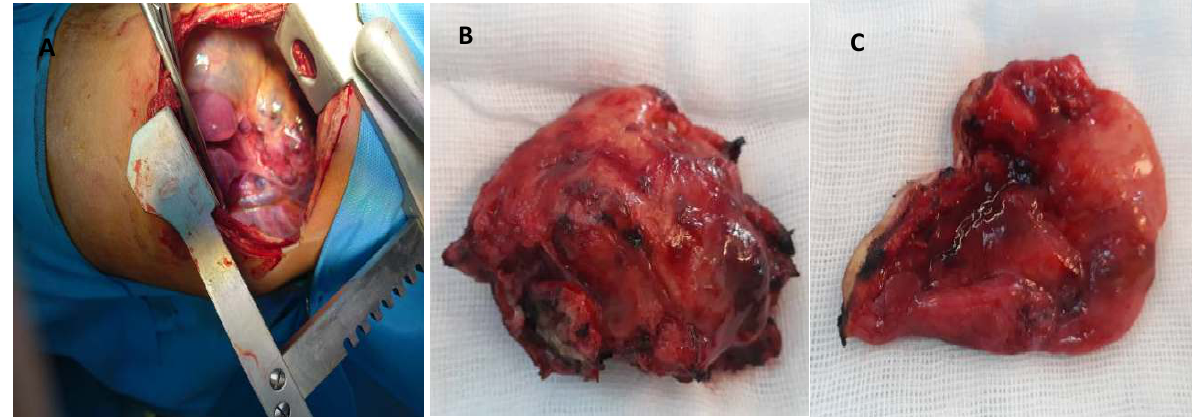
Figure 2: (A) Intraoperative view of Tumor. (B) Anterosuperior mediastinal lesion. (C) Middle mediastinal